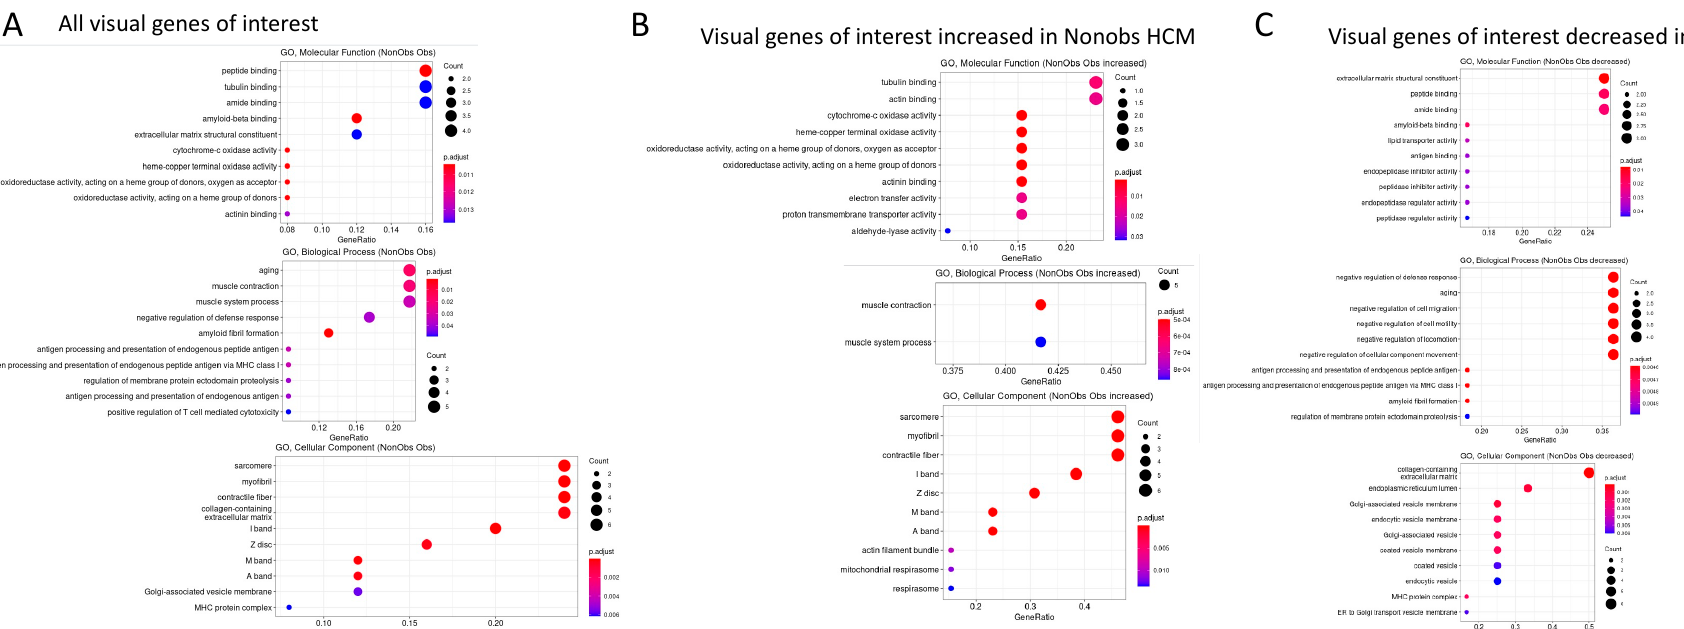
Figure 3. Gene ontology analysis of genes differentially expressed in nonobstructive and obstructive HCM. ( A ) Analysis of molecular functions, biological processes, and cellular components showing significant changes in nonobstructive compared to obstructive HCM. ( B ) GO classifications of genes that are increased in nonobstructive HCM compared to obstructive HCM. ( C ) GO classifications of genes that are decreased in nonobstructive HCM compared to obstructive HCM.